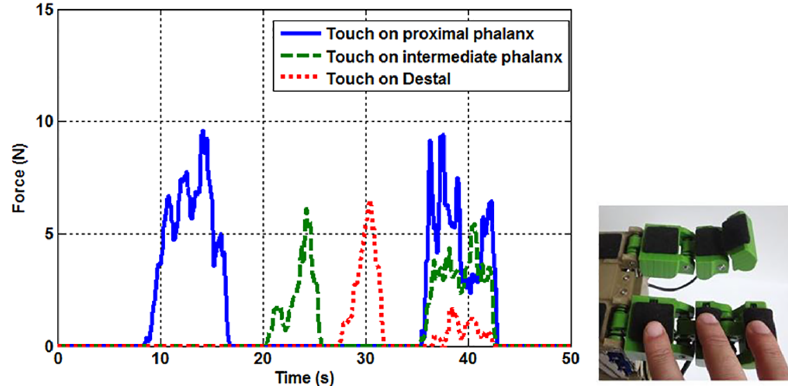
Figure 12. Monitoring touch performance of force signals.